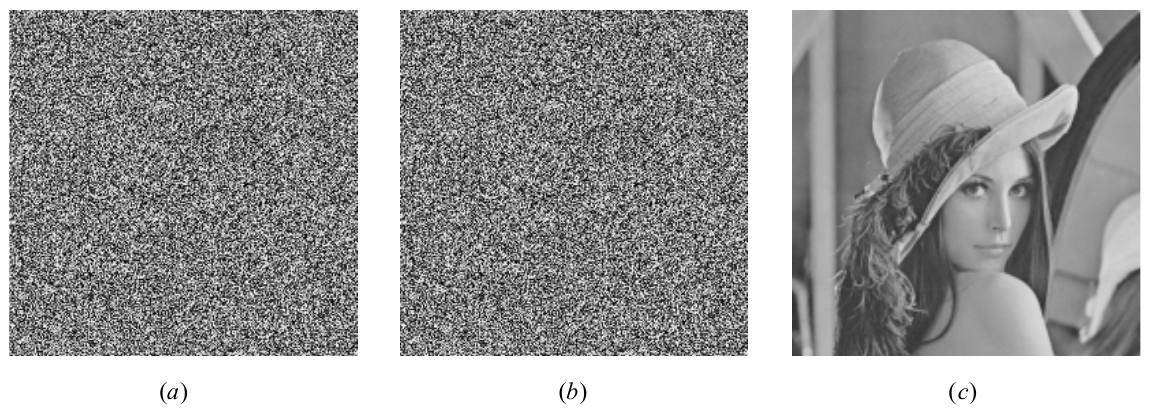
Figure 2. The simulation results in Examples 1, 2, 3, ( a ) the reconstructed image in Example 1 ( b ) the reconstructed image in Example 2 ( c ) the reconstructed image in Example